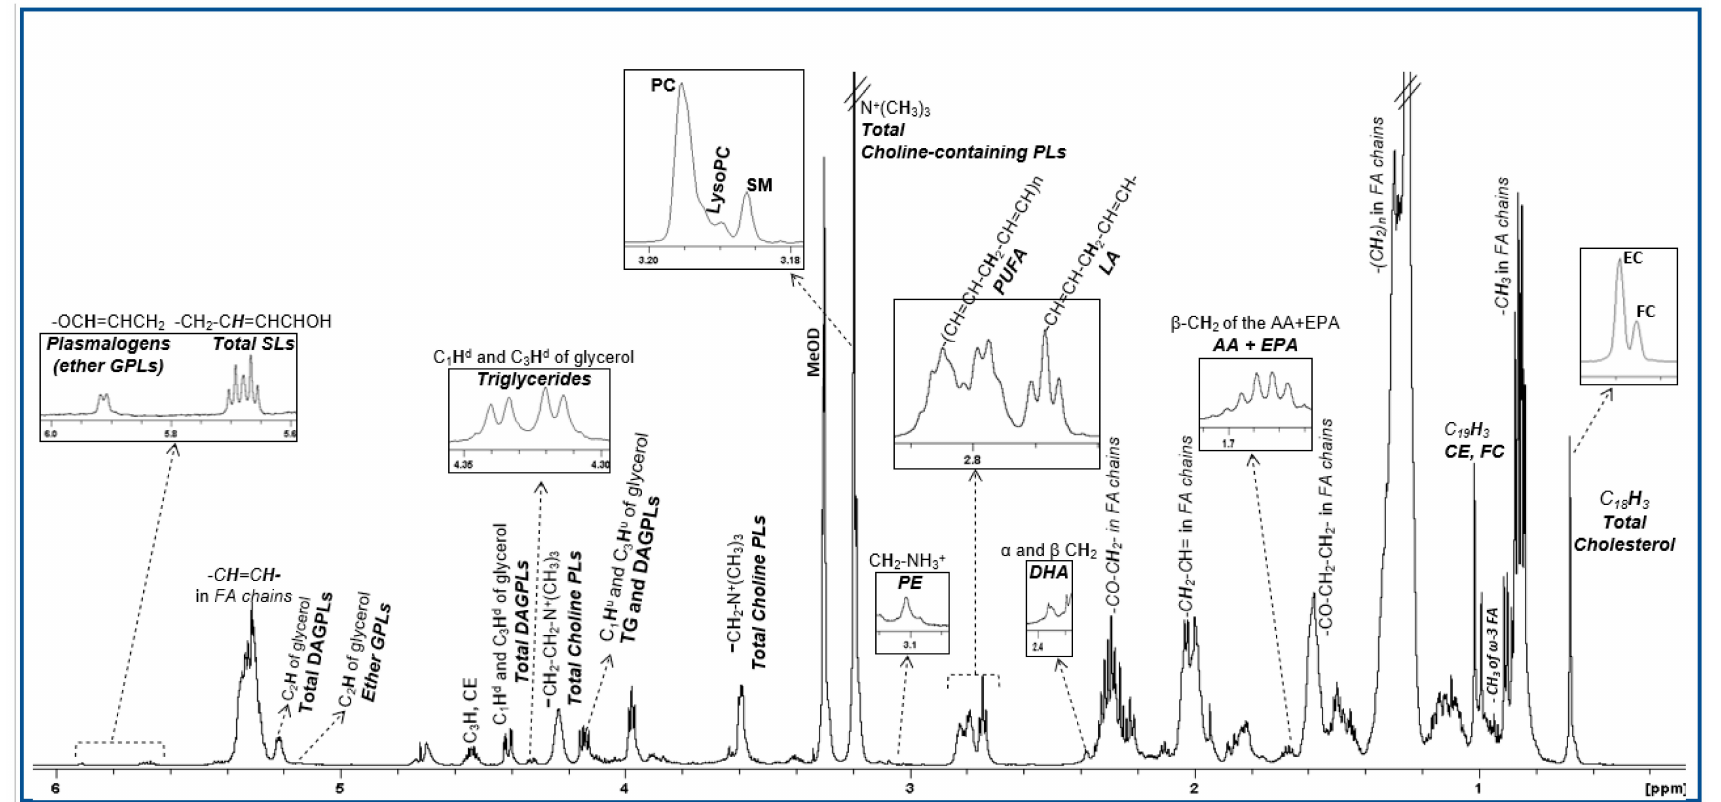
Figure 1. 1 H NMR spectrum of an HDL lipid extract. Peak assignments are summarized in Table